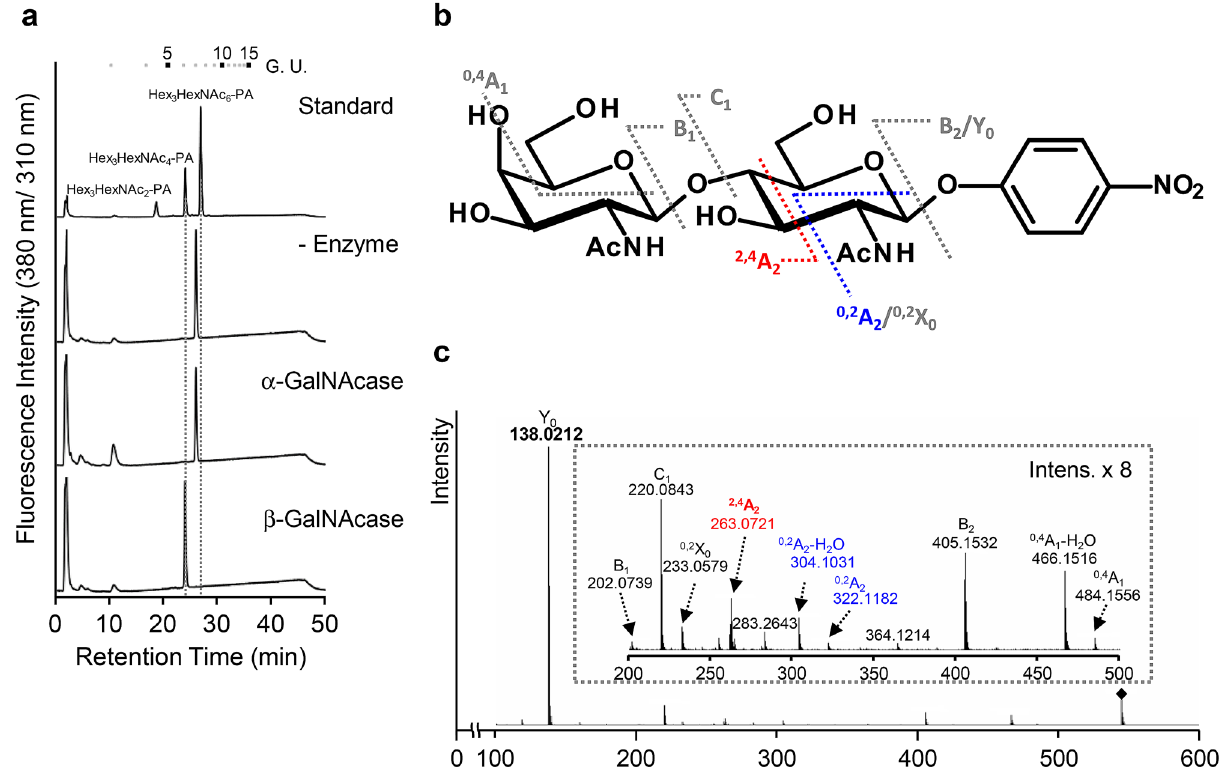
Figure 3. Linkage analysis of the reaction product. ( a ) Linkage-specific N -acetylgalactosaminidase digestion of the reaction product. The reaction product purified by SF-HPLC were digested independently by two N -acetylgalactosaminidases specific for α- and β- linkage. The digested products were separated by SF-HPLC. Numbers at the top represent the elution positions of glucose units. ( b ) Structural representation and fragmentation scheme of GalNAcβ1,4-GlcNAc- p NP. Diagnostic ions are represented in gray characters. ( c ) Negative ion MS/MS fragmentation spectra of N -acetylgalactosaminylated GlcNAc- p NP. The corresponding m/z values of the CID-derived fragment ions and their nomenclatures are assigned in the spectra. The small window shows the enlarged fragment ions in the mass range m/z 200–500. m/z values shown in black and gray indicate 1,4-linked specific and GalNAcβ-GlcNAc- p NP signals,